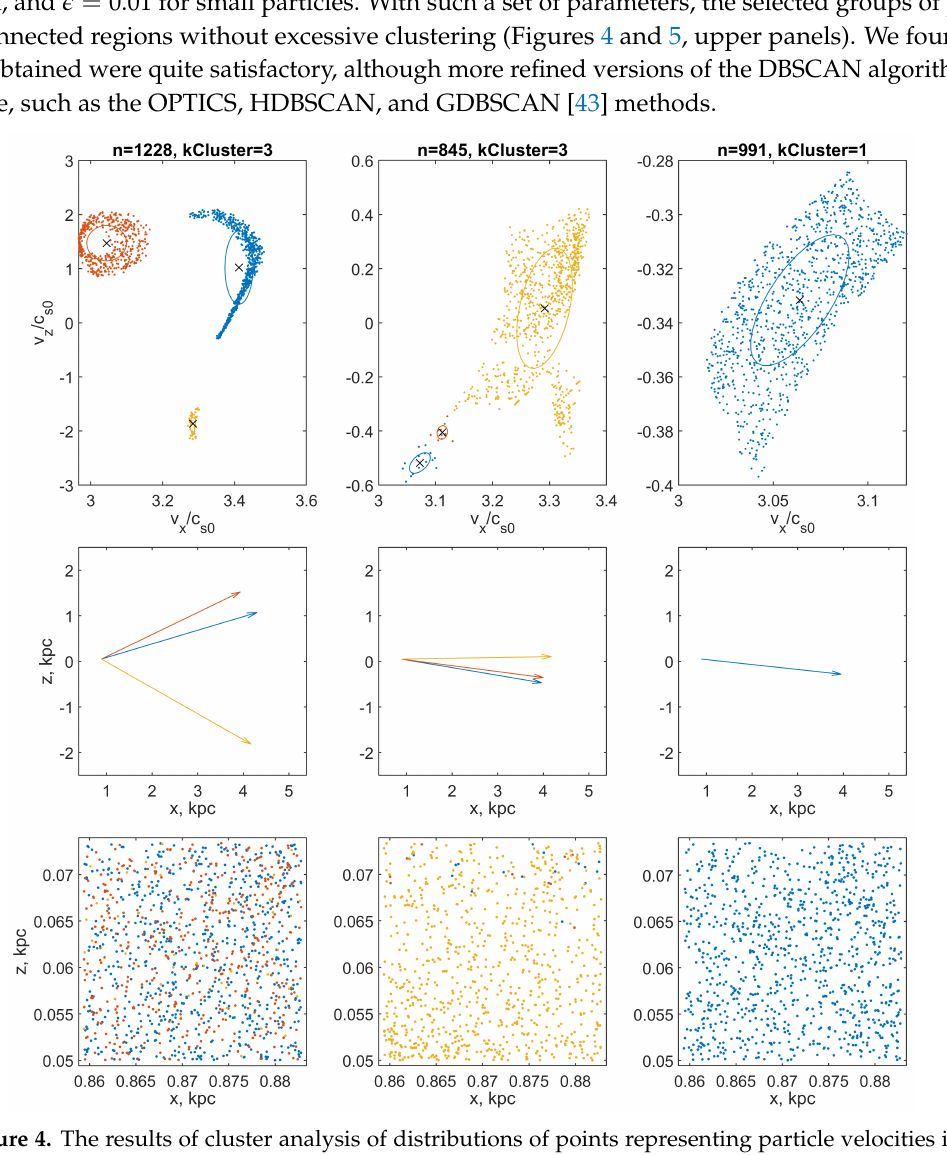
Figure 4. The results of cluster analysis of distributions of points representing particle velocities in velocity space. The points are grouped into clusters using the DBSCAN procedure. The color of the dots indicates the belonging of a drawing element (point, vector, or ellipse) to a specific cluster (particle beam). Top row: selected clusters of points ( n is the total number of points in the computational domain, kCluster is the number of found clusters) in the velocity space. The × markers indicate